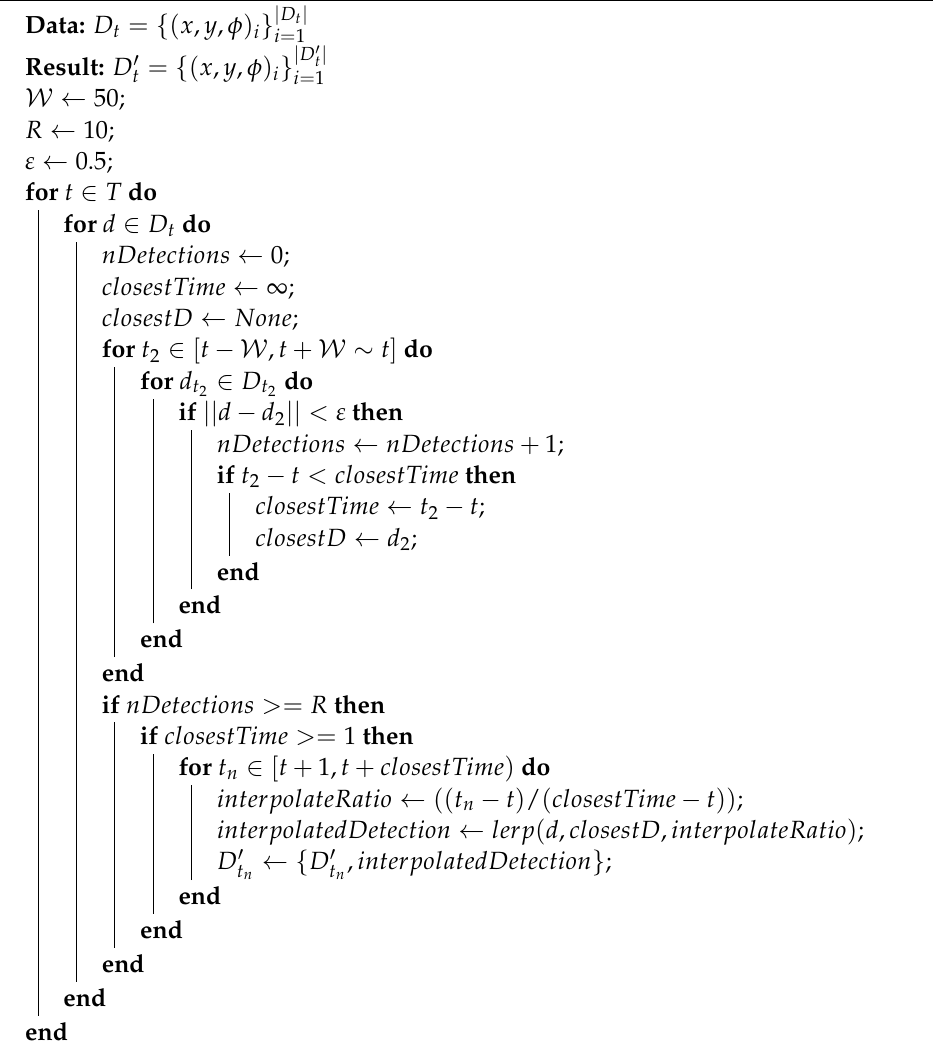
Algorithm 1: The interpolation operation of our temporal filter, where ε gives our detection distance threshold, R is the required number of detections, and W is our sliding window size. Here, lerp is a function that takes two detections at different time points and linearly interpolates the new ( x , y , φ ) at the given time